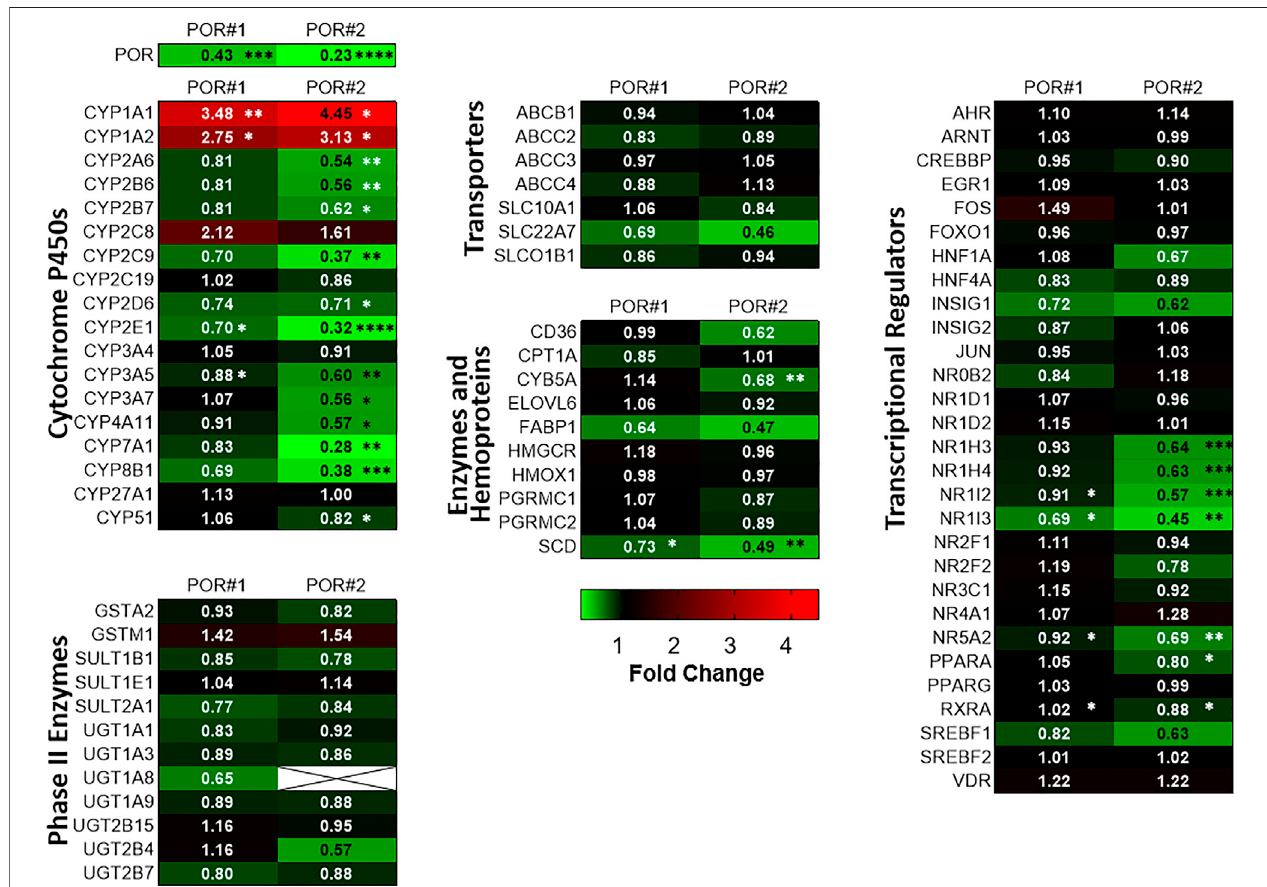
FIGURE1| Differential geneexpression pro fi les inHepRG − POR cells. Geneexpression analysisofHepaRG cells transduced withsgRNAsPOR#1and POR#2 and vector control (VC) and differentiated for 2 weeks was performed by qPCR. Data of six independent experiments were normalized to the geometric mean of GAPDH, RPLP0 and ACTB expression. The expression of the indicated genes of different classes as indicated is shown as fold changes relative to VC and represented as heat map (color code indicated below). Statistical signi fi cance was assessed by paired t -test (* p < 0.05, ** p < 0.01, *** p < 0.001. **** p < 0.0001).